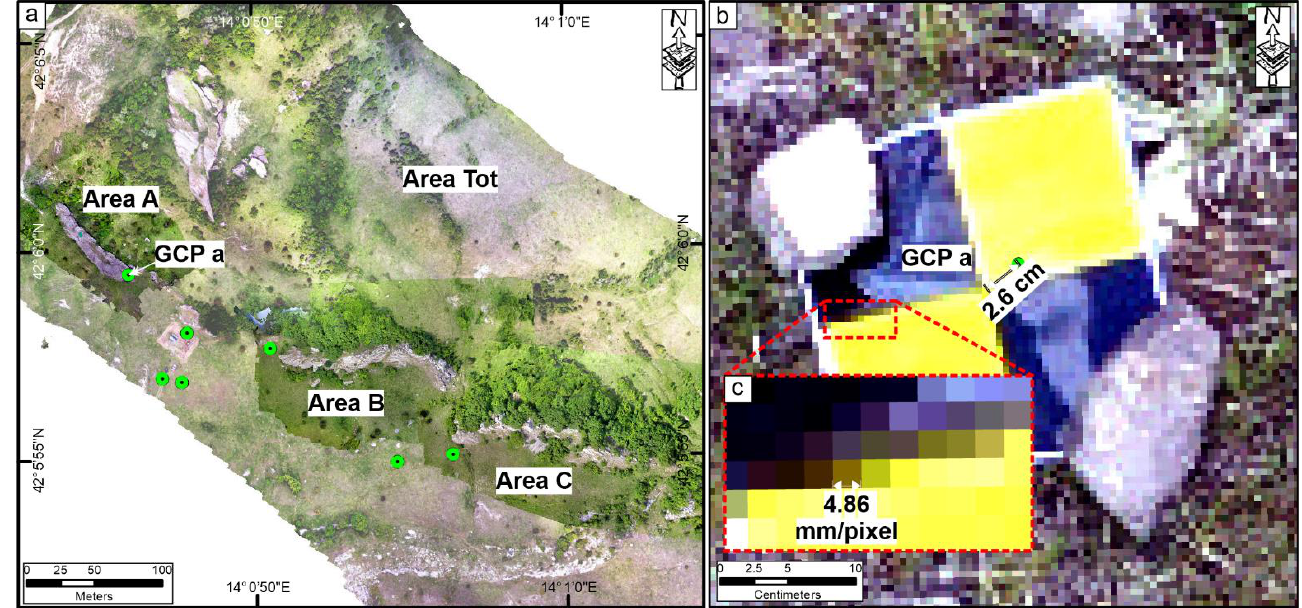
Figure 6. ( a ) Location of the GCPs/checkpoints in the study area (green circles). ( b ) Detail of a GCP (25 × 25 cm) with the green circle showing the point surveyed with Emlid Reach RS2 GNSS/RTK L1, L2, L5 system; 2.6 cm is the difference between the measurement with GNSS and PPK techniques (see main text). ( c ) Details showing the 4.86 mm/pixel resolution of the orthomosaic for GCP a (location in panel ( a )).